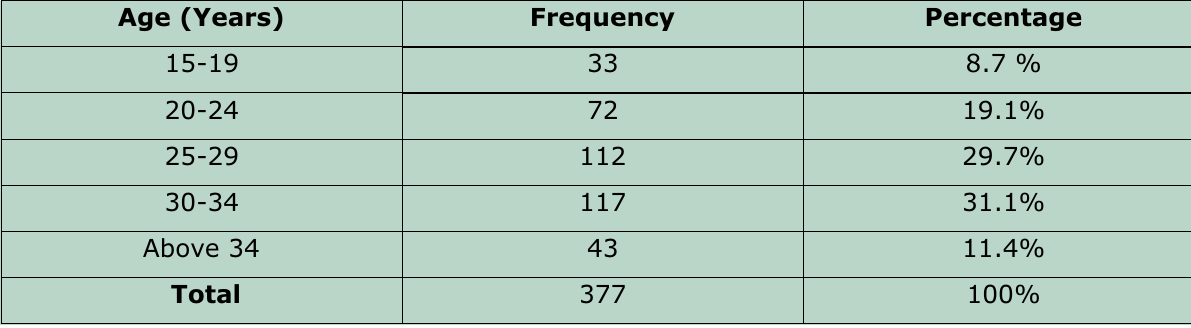
Table-I: Age distribution of respondents (n=377).